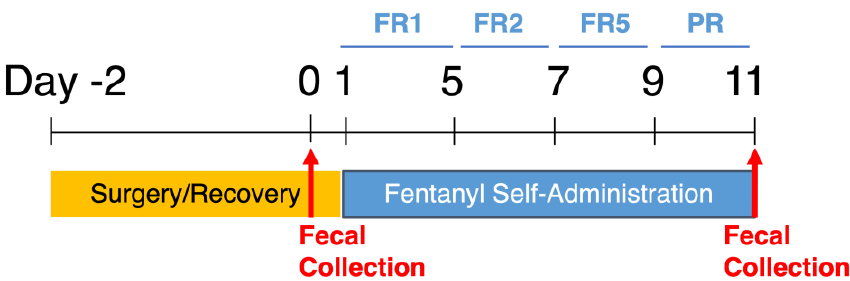
Figure 1. Experimental timeline for fentanyl self-administration and fecal sample collection. Animals undergo catheter implantation surgery and recover for 2 full days before starting self-administration. Animals self-administer fentanyl at fixed ratio (FR) 1 for 5 days, FR2 for 2 days, FR5 for 2 days, and progressive ratio (PR) for 2 days, for 11 days total. One fecal sample is collected from each animal the day before self-administration (day 0) and the last day of PR (day 11).